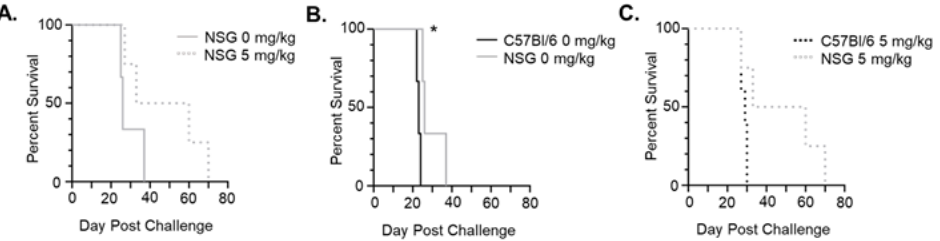
Figure 5. 5-Aza extends survival in half of immuno-deficient mice. ( A ) NSG mice were challenged with 8 × 10 5 C1498-FLuc cells via tail vein and treated with vehicle (0 mg/kg) ( n = 3 mice) or 5 mg/kg 5-Aza ( n = 4 ) for three consecutive days beginning on day 4 post-challenge. Percent survival by days post-challenge is shown as a Kaplan–Meier curve. ( B ) Comparison of survival between vehicle (0mg/kg) treated C57Bl/6 and NSG mice challenged with C1498-Fluc. ( C ) Comparison of survival between 5-Aza-treated (5 mg/kg) C57Bl/6 and NSG mice challenged with C1498-Fluc. * p < 0.05, Log- rank (Mantel-Cox) test and Gehan-Breslow-Wilcoxon